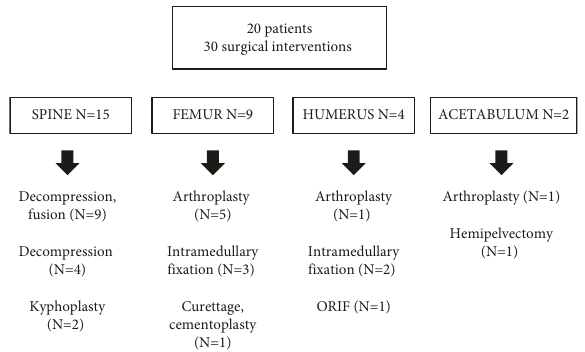
Figure 2: Surgical management of metastatic leiomyosarcoma to the